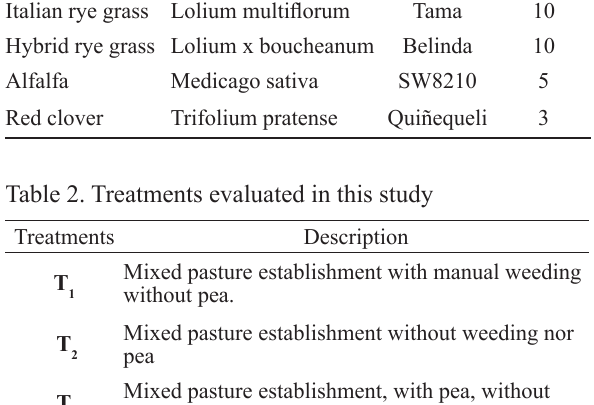
Table 1. Amount, species and cultivars present in the grass- legume mixed pasture sown in the Mantaro valley, Junín, 2012